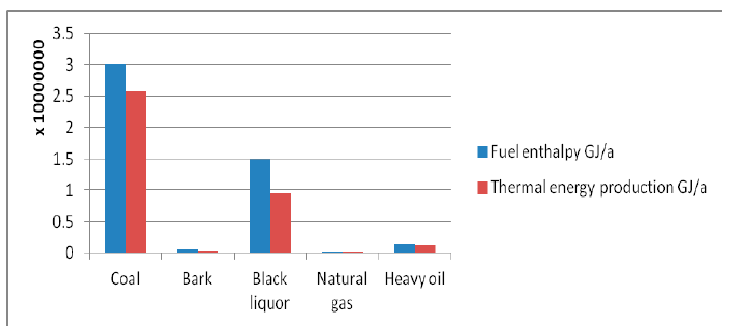
Figure 3. Main fuel thermal enthalpy and thermal energy production.